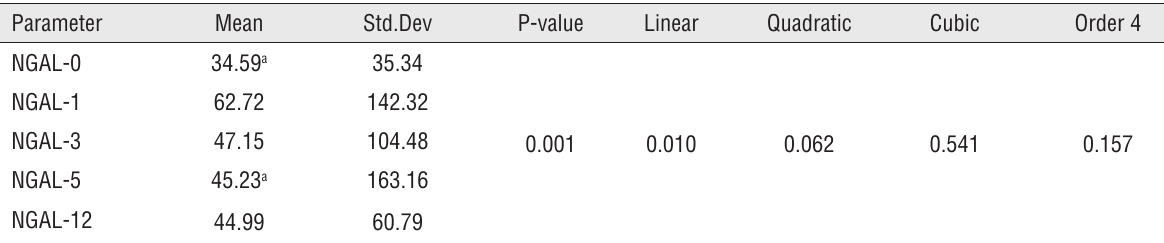
Table 1 - Time-linked variation in NGAL (ng/dL) measured in urine. Parameter Mean Std.Dev P-value Linear Quadratic Cubic Order